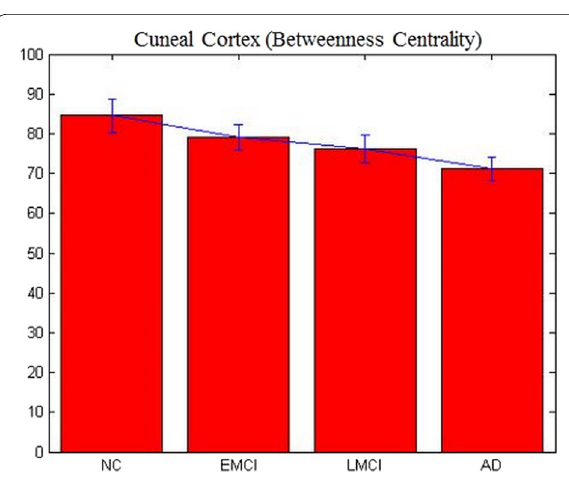
Fig. 5 Betweenness centrality (BC) of cuneus obtained from undirected networks using functional connectivity (Pearson’s correlation), which was not significantly different between the groups ( p >